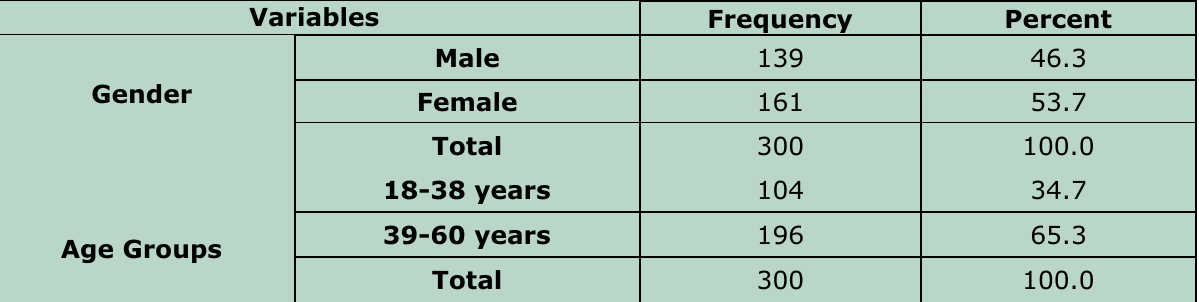
Table-I: Frequency distribution of gender and age groups.